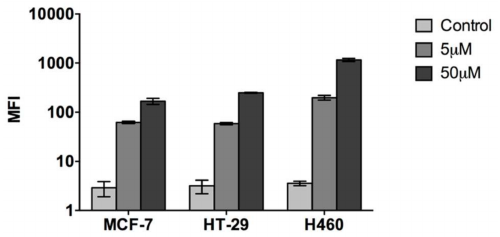
Figure 3. CIGB-552 cell penetrating capacity was evaluated by flow cytometry in the three cell lines used. Median fluorescence intensity values (MFI) showed that H460 cell line possess the highest internalization levels at both concentrations whereas HT-29 and MCF-7 showed similar levels of internalization. Results showed a direct correlation between concentration increase and internalization levels.